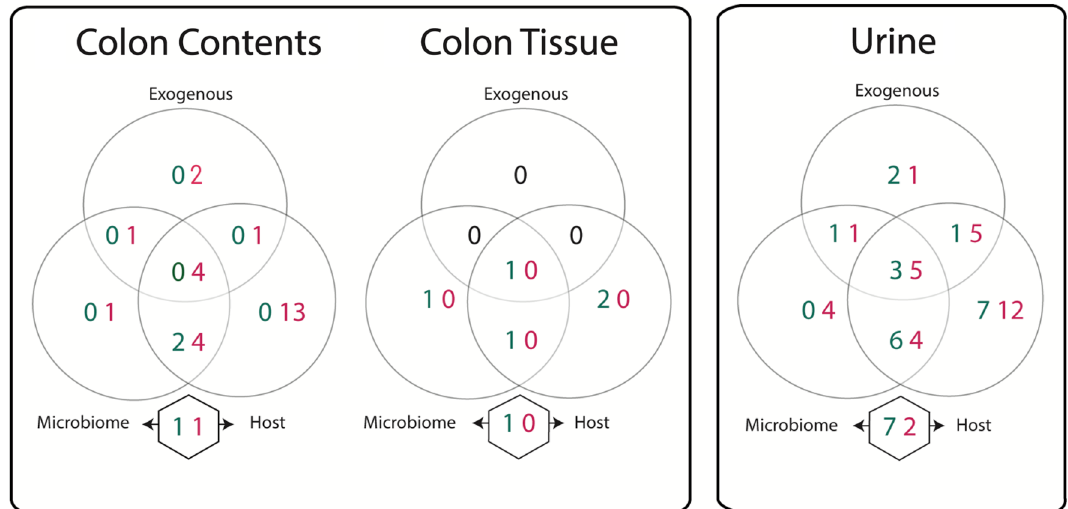
Figure 3. Biochemical origins of metabolites observed to differ in the colon contents, colon tissue, and urine of UNNC10201652 treated animals compared to control. Values indicate the number of metabolites increased (green) or decreased (red) with treatment and the circles indicate the source of those metabolites (i.e. if derived from the microbiome, host, or exogenously/diet). Metabolites included in the overlapping areas can be derived from either source while the metabolites listed in the hexagons are those arising from microbial-host co-metabolism. A metabolite list is provided in Supplementary Table